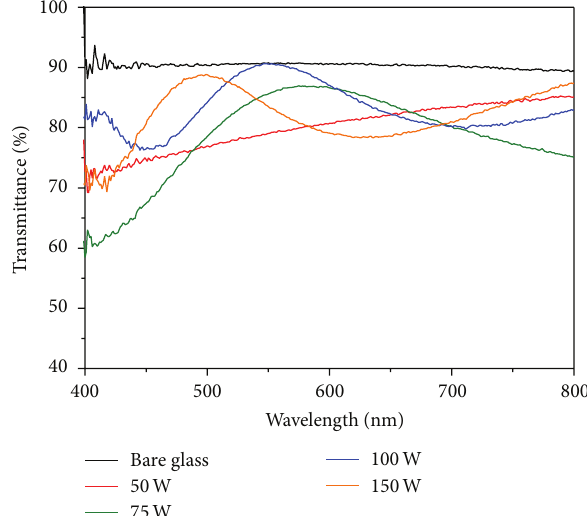
Figure 6: Optical transmittance spectra for the pure-bare glass substrate and ZnO thin films with different RF powers ranged from 50 to 150W, respectively.